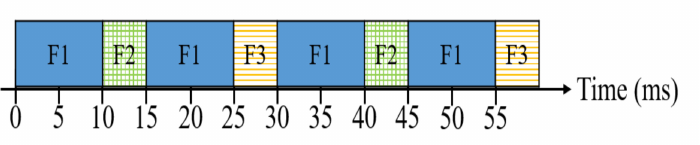
Figure 1. The example of the conflict-free